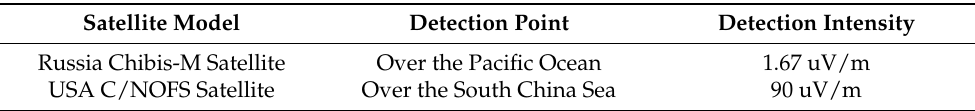
Table 3. Satellite power frequency detection in various countries.